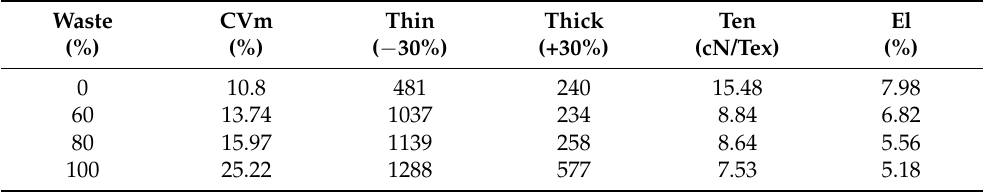
Table 7. The quality of blended yarn (W2 and V1 Table 6. The quality of blended yarn (W1 and V1 blend).